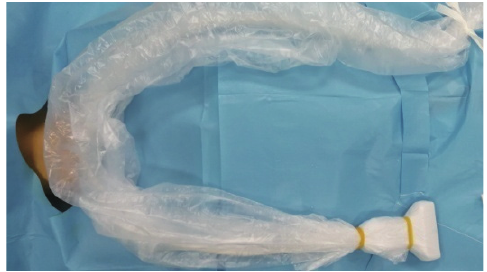
Figure 6 Ultrasonic probe and cable wrapped by isolation sleeve.